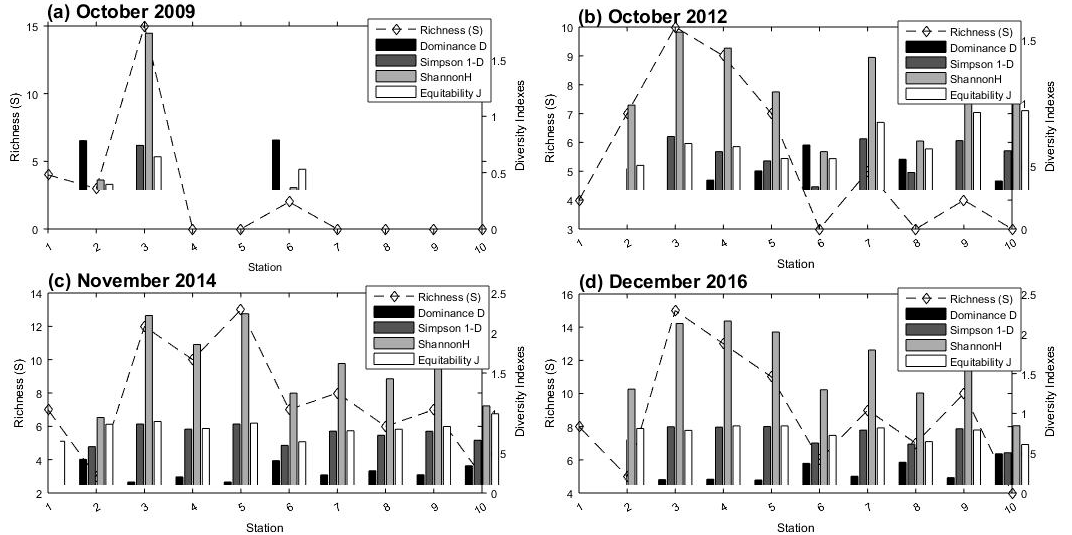
Figure 12. Diversity indices (richness, abundance, S’ and H’ diversity, dominance (D), and evenness (J)) for: ( a ) sampling stations 2009, ( b ) sampling stations 2012, ( c ) sampling stations 2014 and ( d ) sampling stations 2016. The floristic and vegetation comparison between the pre-earthquake (2009) and postearthquake (2012) periods did not present great differences.